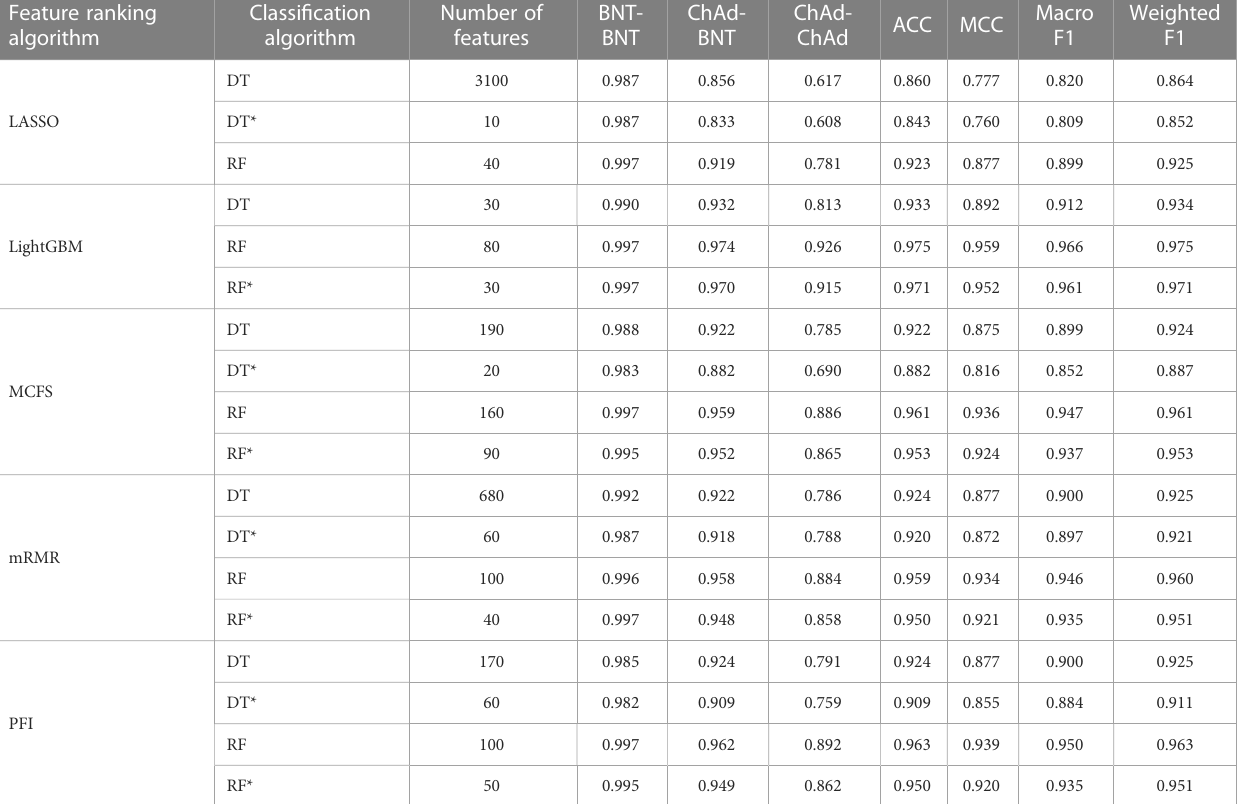
TABLE 4 Performance of key classi fi ers in CD8 + T cell.